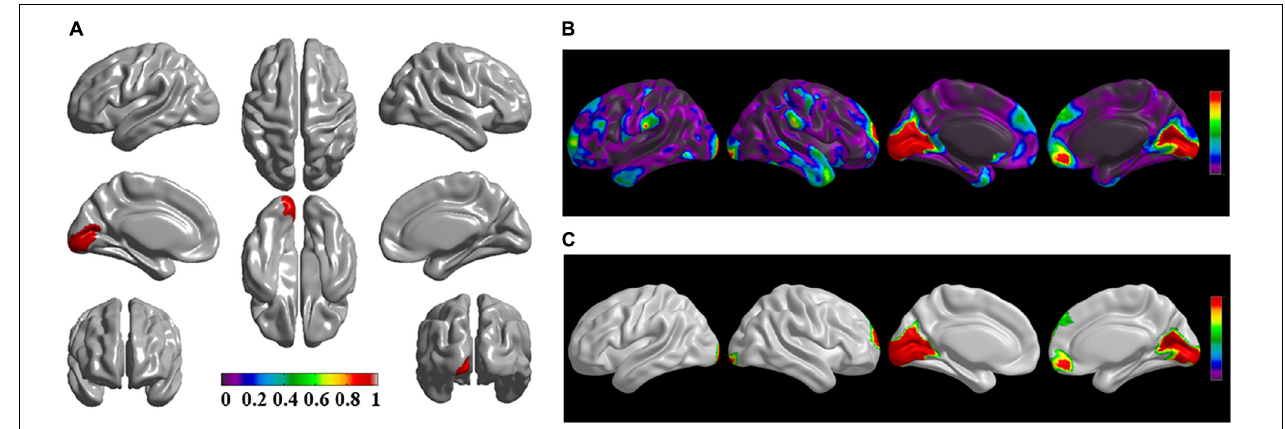
FIGURE 7 | The significantly altered brain regions of cortical structural connectivity in the sPD brain based on seed 7. (A) The brain regions of seed 7, the red brain regions represent the cortical thickness thinning regions. (B) The significantly altered brain regions in the F-map based on seed 7, the red, and green brain regions represent the brain regions of significant cortical structural connectivity alteration that were not corrected by the FWE. (C) The significantly altered brain regions after FWE correction based on seed 7, the red and green brain regions represent the brain regions of significant cortical structural connectivity alteration that were corrected by the